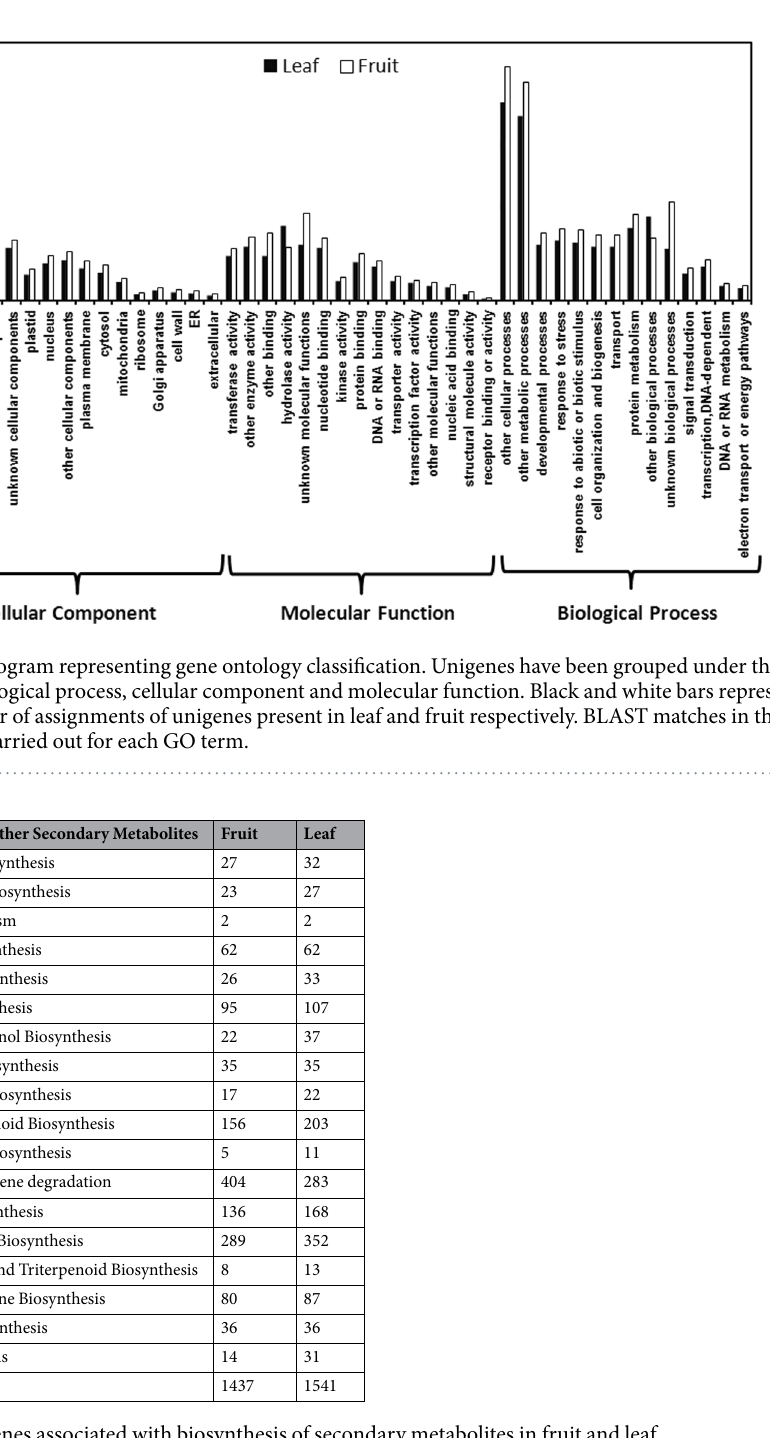
Table 1. Unigenes associated with biosynthesis of secondary metabolites in fruit and